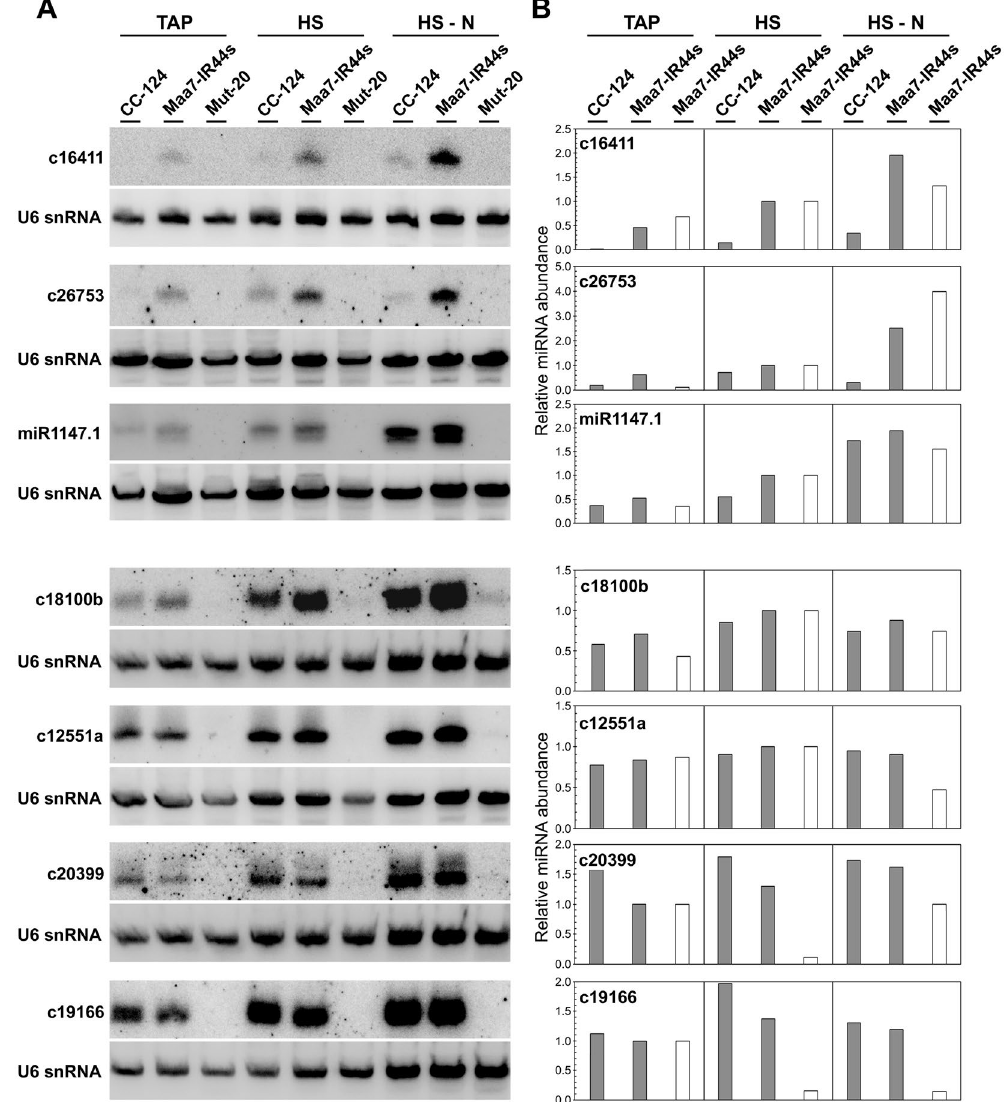
Figure 2. Northern blot analysis of miRNA expression in Chlamydomonas cells grown under the denoted trophic conditions. ( A ) Small RNAs were detected with probes specific for the indicated miRNAs. The same filters were reprobed with the U6 small nuclear RNA sequence as a control for lane loading. CC-124 wild type strain; Maa7-IR44s, CC-124 containing a transgene expressing FLAG-tagged AGO3; Mut-20, TSN1 deletion mutant, in the Maa7-IR44s background, defective in sRNA biogenesis 14 . ( B ) Relative miRNA levels in the indicated strains under the different trophic conditions. Values shown are the average of two independent experiments and are normalized to those of the Maa7-IR44s strain grown photoautotrophically in nutrient replete minimal medium (HS). For c20399 and c19166, values are normalized to those of Maa7-IR44s grown mixotrophically in acetate containing medium (TAP). The relative standard deviation, as percentage of the mean, was in no case higher than 28.3%. Data corresponds to phosphorimager measurements of sRNA signals on northern blots (gray bars) or normalized read counts from the AGO3-associated sRNA libraries (white